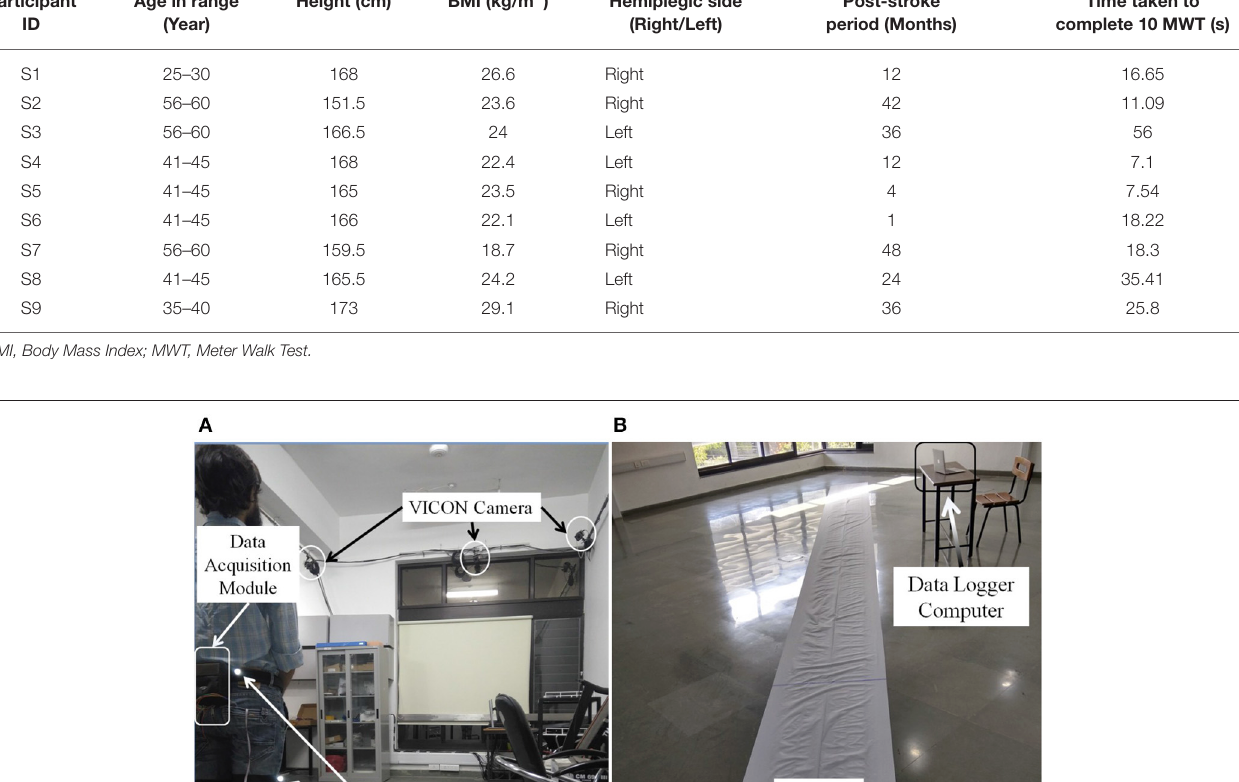
Frontiers in Neuroscience |